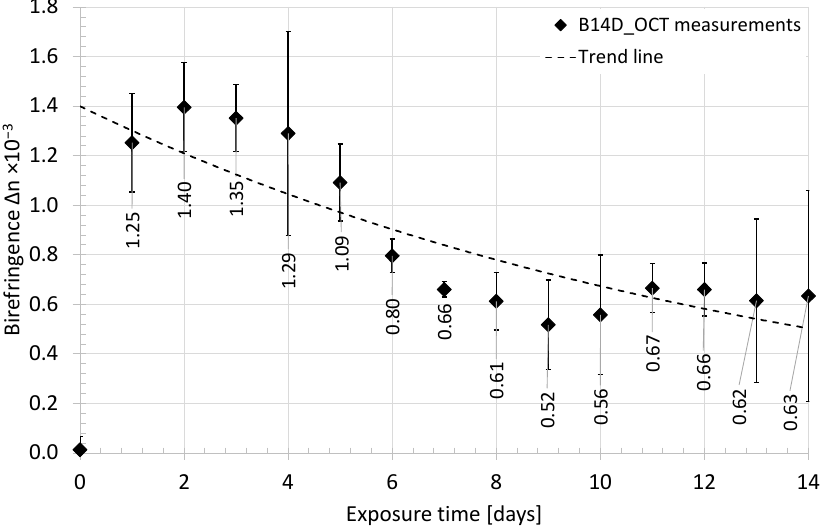
Figure 10. The average value of birefringence of the chicken humerus recorded for 14 days of exposure to acid—sample B14D_OCT.